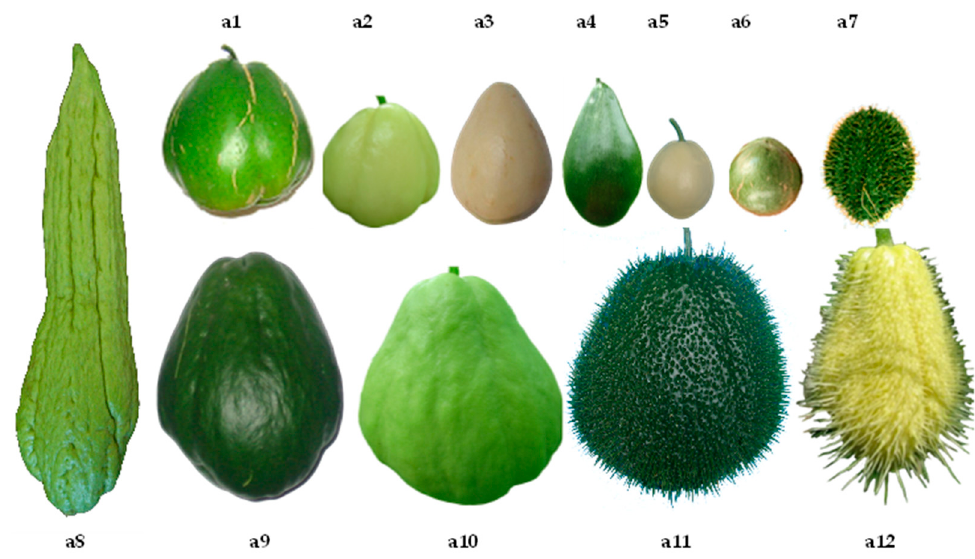
Figure 6. Fruit characteristics (shape, color, size, furrows, and spines) of the varieties of Sechium edule regarding their wild predecessor ( a7 ). Medium, small, and very small fruit: ( a1 – a6 ) ( nigrum levis , albus levis , albus dulcis , nigrum conus , albus minor, nigrum minor ), big fruit ( a8 – a12 ) ( nigrum max- ima, nigrum xalapensis, virens levis, nigrum spinosum, albus spinosum ) (According to [11]).